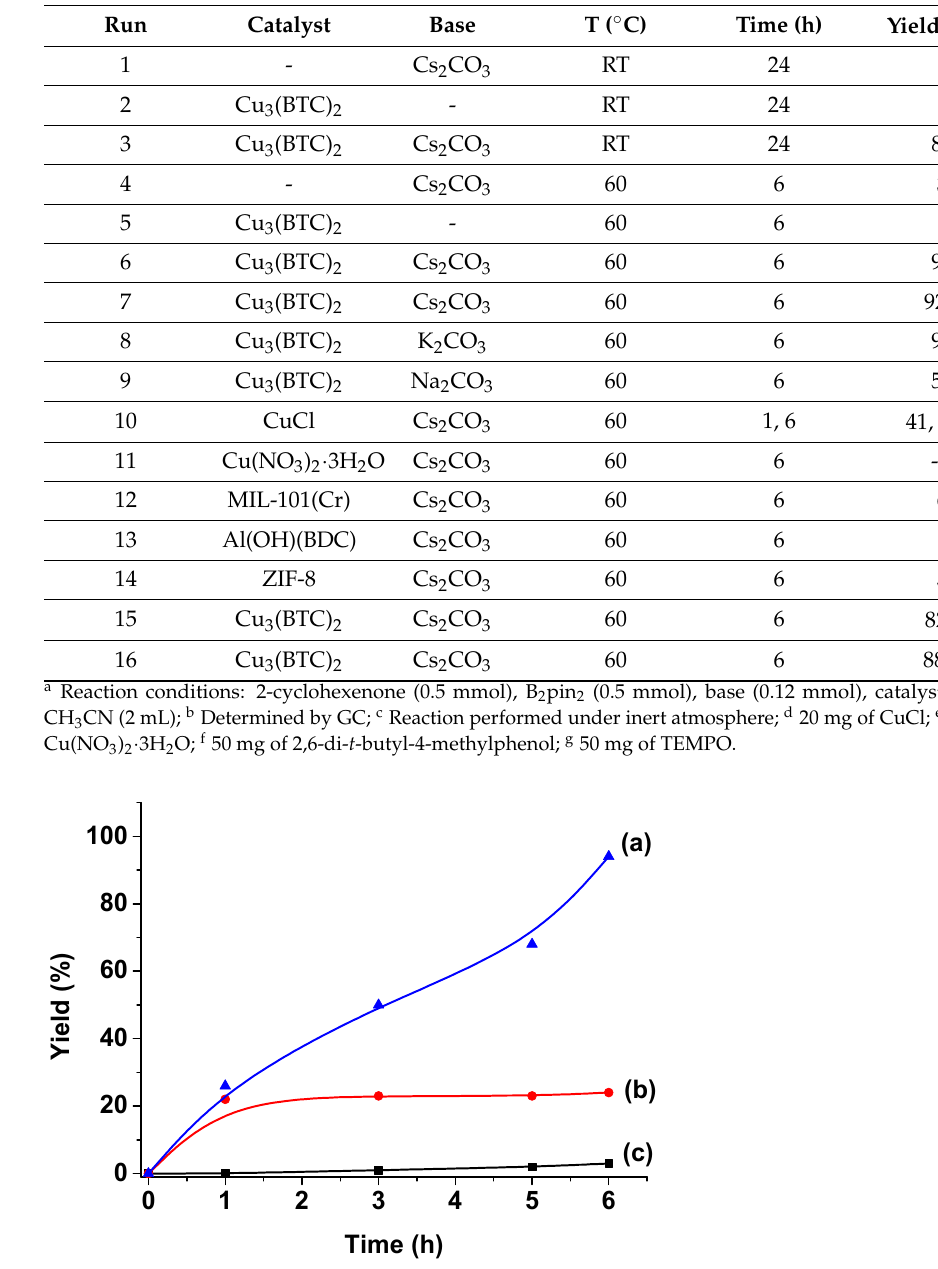
Figure 1. (a) Time yield plot for the formation of the desired product, (b) hot-filtration test at 1 h reaction and (c) the corresponding blank control experiment in the absence of the catalyst under identical reaction conditions.